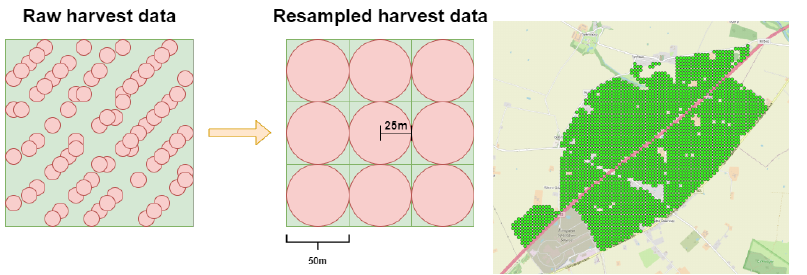
Figure 6. Illustration of the unevenly distributed points in the raw yield data and how they were resampled into a 50 × 50 m 2 grid.